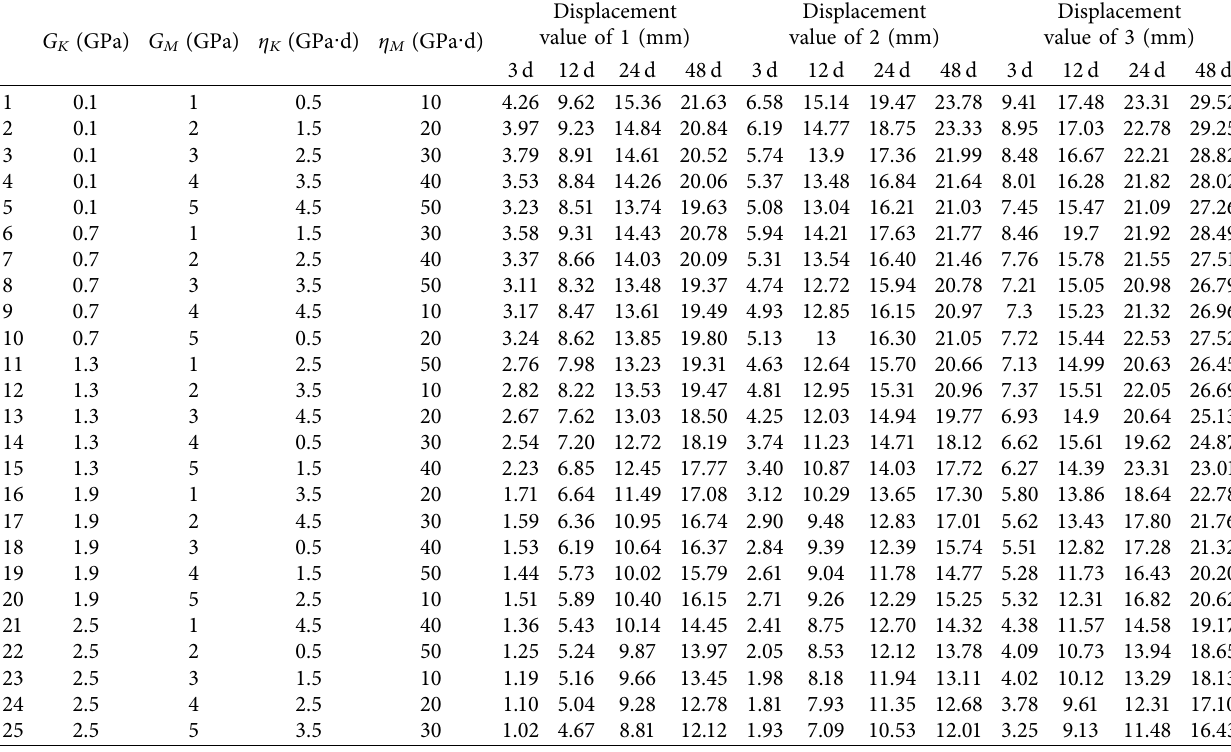
Table 3: The orthogonal parameter sample.